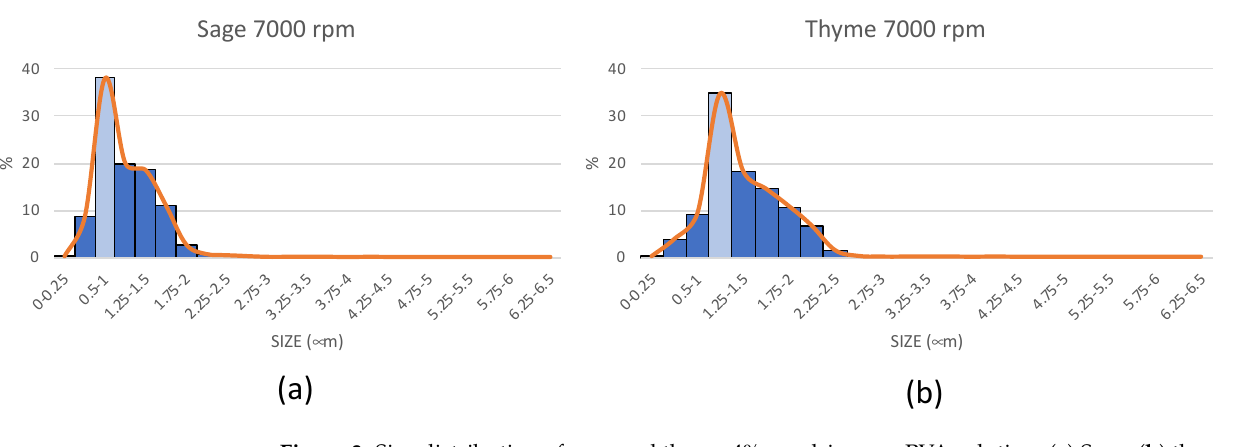
Figure 3. Size distribution of sage and thyme 4% emulsions on PVA solution. ( a ) Sage; ( b ) thyme.